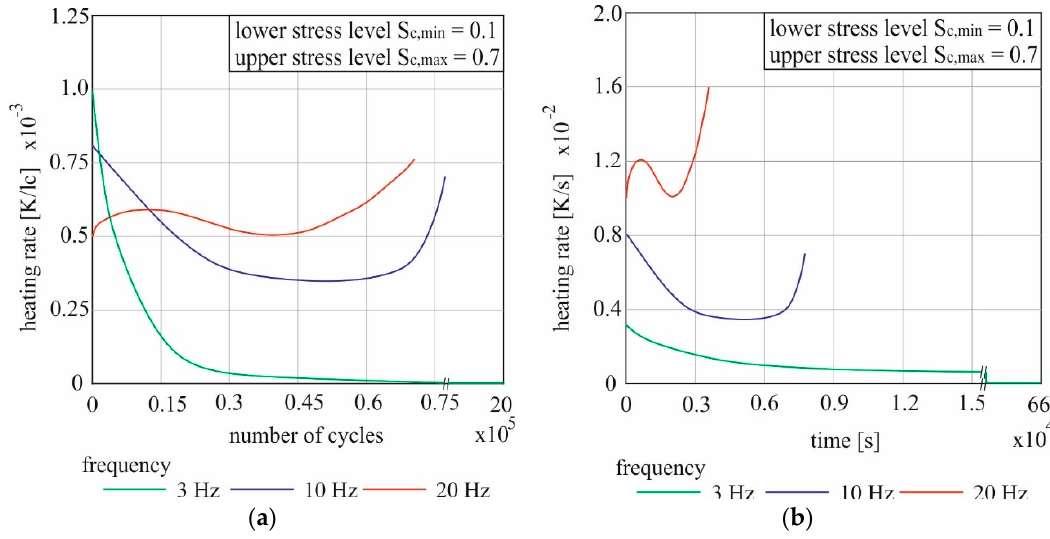
Figure 8. Heating rate of UHPC 1 specimens for test frequency f P = 3 Hz, f P = 10 Hz and f P = 20 Hz and relation between lower and upper stress level S c,min /S c,max = 0.1/0.7, ( a ) related to the load cycles (lc); ( b ) related to the time (s).